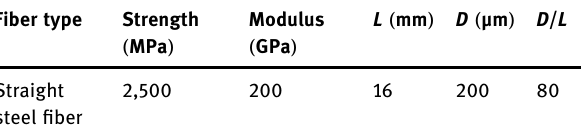
Table 4: Steel fi ber